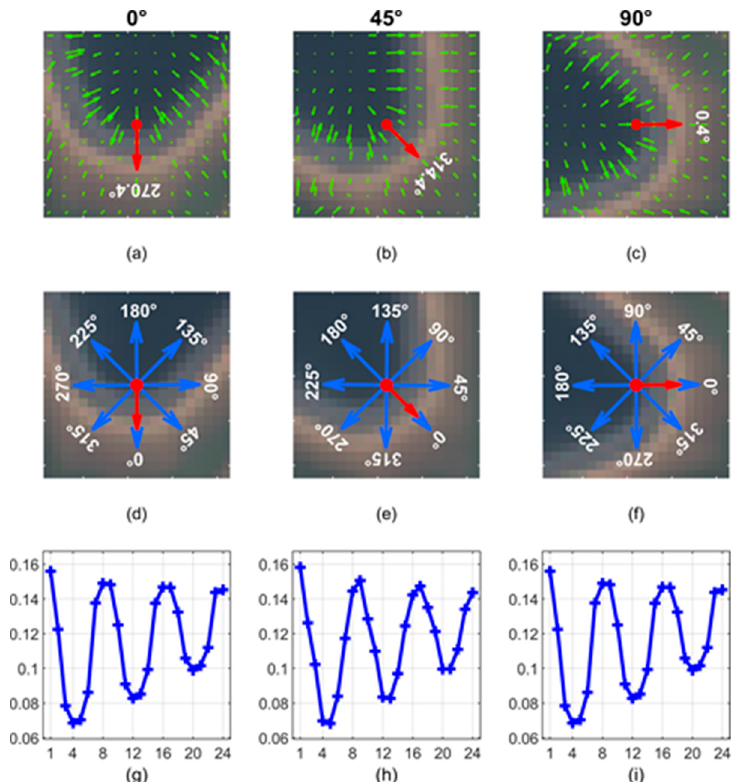
Figure 3. Computation steps for RISFL extraction for a pixel in a heterogeneous area across an edge, with 0 ⁰ , 45 ⁰ , and 90 ⁰ rotation. (a – c) Local gradients (green arrows) and magnification of gradient at center pixel (red arrow), (d – f) azimuths in a rotated local system, and (g – i) RISFLs obtained for the center pixel of a 5 × 5 N with n = 8.